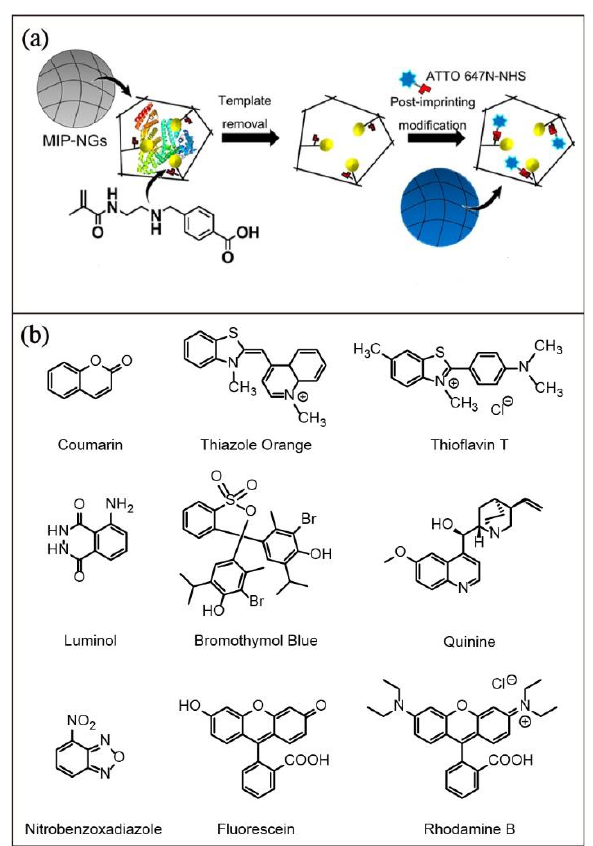
Figure 8. ( a ) Preparation of fluorescent MIP conjugated with ATTO 647N fluorescent dye for porcine serum albumin quantification. Adapted with permission [89]. Copyright 2021, Elsevier. ( b ) Structures of the commonly used organic fluorophores in the development of fluorescent MIPs.